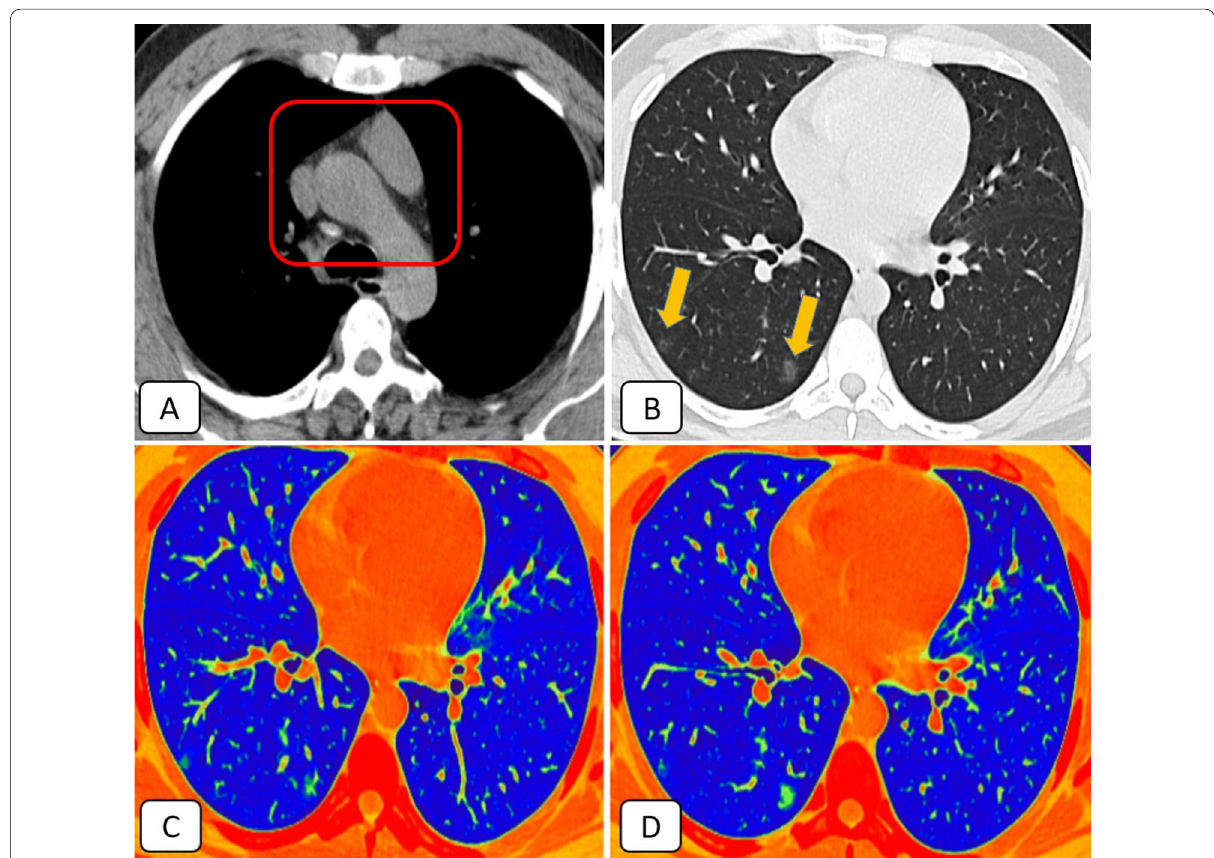
Fig. 5 A 53-year-old male COVID-19 patient complained of fever, cough, loss of taste and smell: A Axial mediastinal window CT showed mixed soft tissue and fatty replacement of the thymic gland. The solid component is > 50% (grade 1) [red square]. B Axial lung window CT showed two right basal sub-pleural small ground-glass nodular opacities (orange arrows). C – D Axial 3D volumetry cuts highlighted the right basal small sub-pleural ground-glass opacities. The pathological lung volume was around 0.5% of the total lung